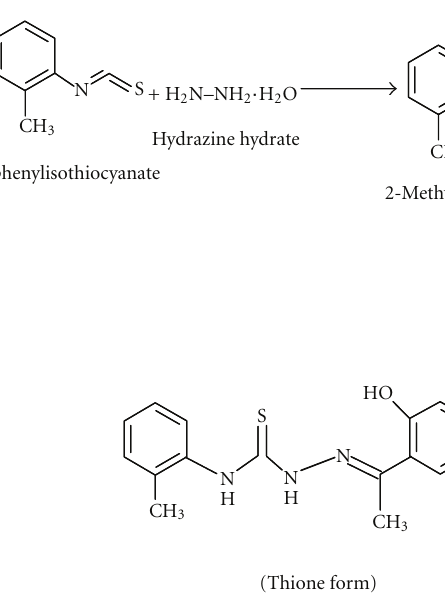
Scheme 1: Synthesis of 2-hydroxyacetophenone-2-methylphenylthiosemicarbazone (H 2 dampt) ligand ( 1 ).